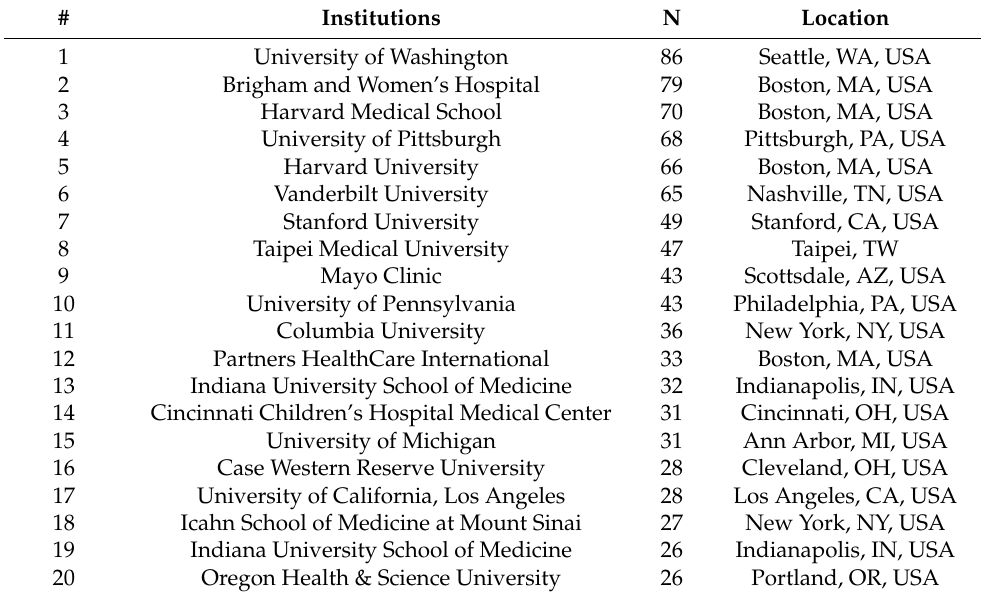
Table 2. Most influential institutions (sorted by the number of